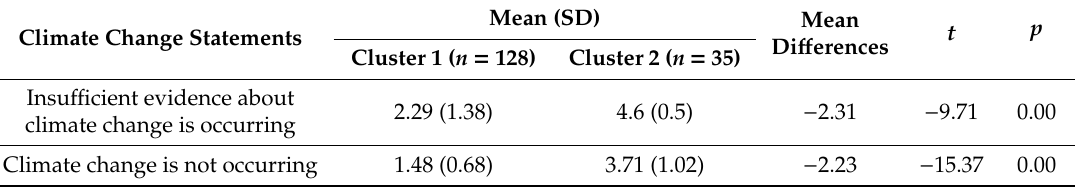
Table 4. K-mean cluster analysis